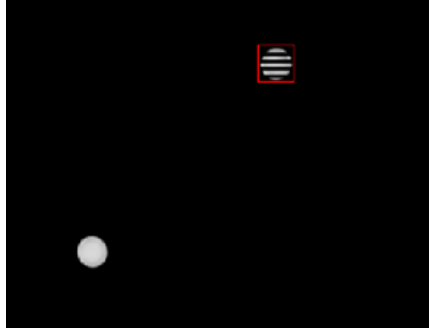
Figure 10. The tracking performance when the LED was not shielded.